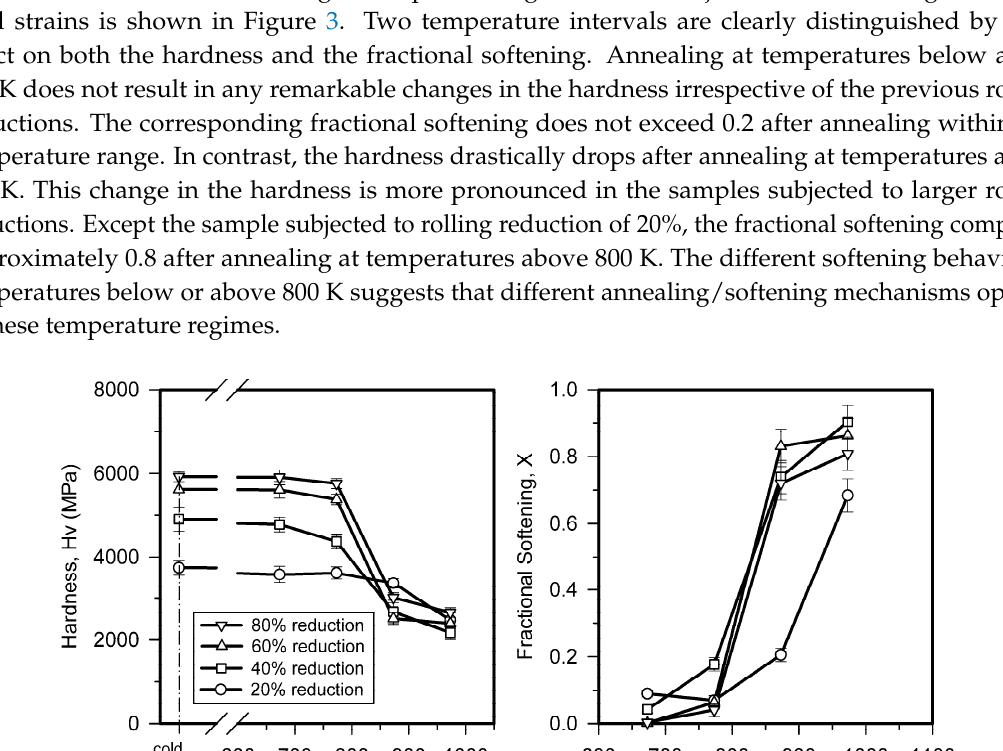
Figure 3. Hardness change and annealing softening for a high-Mn steel subjected to various cold rolling reductions and then annealed for 30 min at 673–973 K.